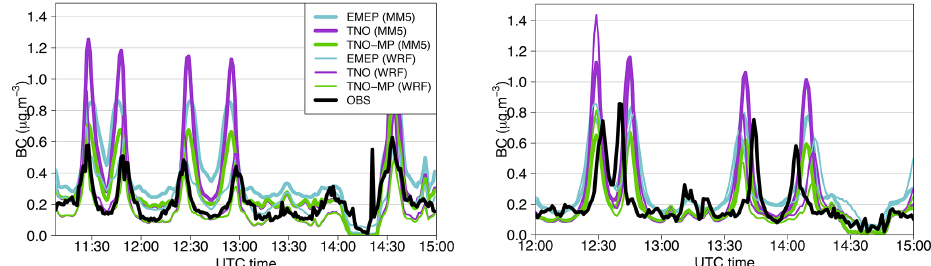
Figure 6. Observed (in black) and simulated BC concentrations along the aircraft trajectory for 10 (left panel) and 13 July (right panel).